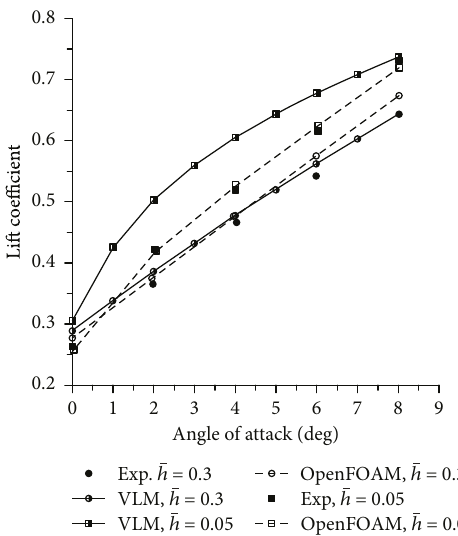
Figure 4: Lift coe ffi cient of the wing with the aspect ratio of 1.5 and pro fi le NACA 6409 versus the angle of attack (or the pitch angle). Comparison between VLM and OpenFOAM simulations and experiment [22].